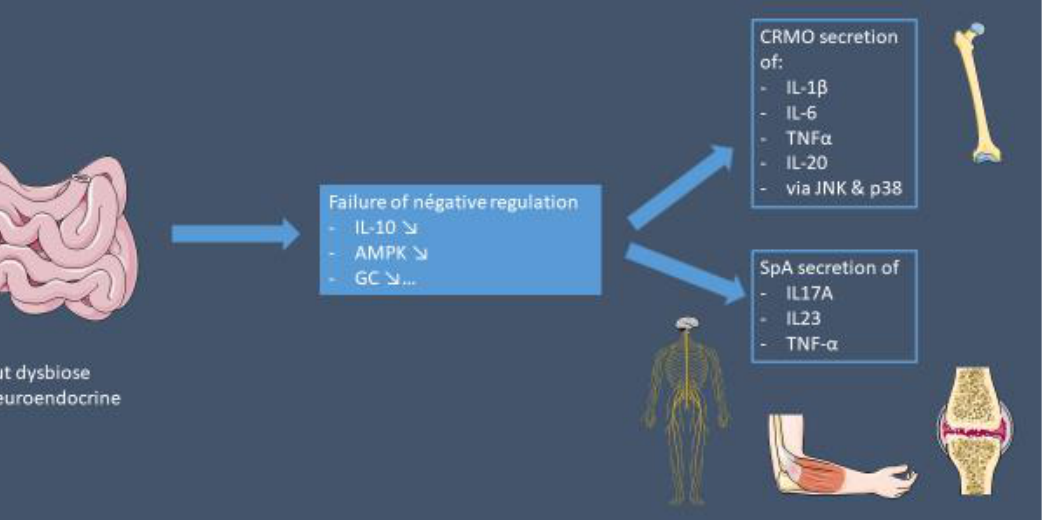
Figure 6. Similarities between CRMO and SpA. Intestinal dysbiosis may be the common factor in the expression of these two conditions. Depending on the genetic predisposition (HLAB27, NLPR3 methylation, ERAP1, etc.) and the environment, this intestinal inflammation could be the cause of chronic